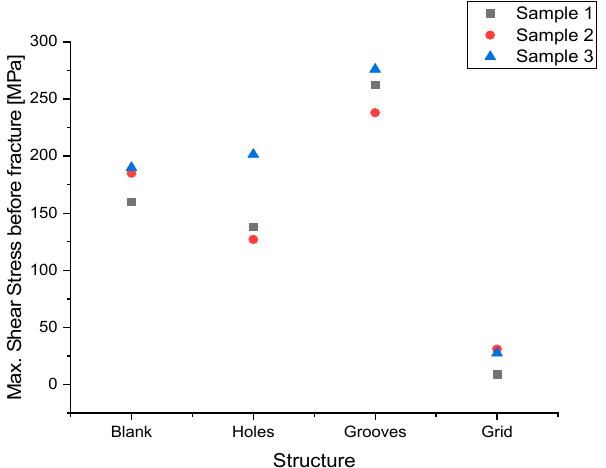
Figure 6. Shear strengths of the carbide / steel brazed joints having no structure (blank), holes, grooves and grid patterns on carbide surface.